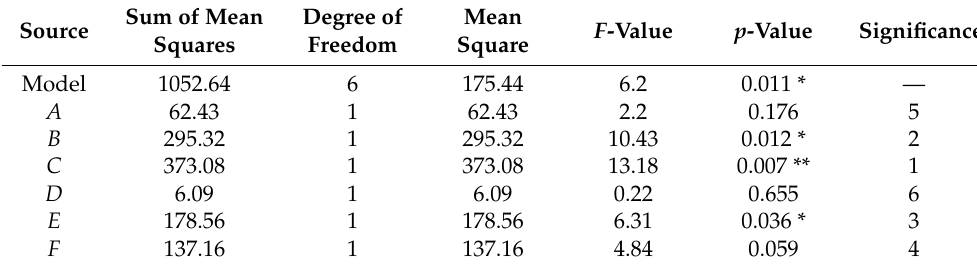
Table 4. Parameter significance test of the Plackett–Burman